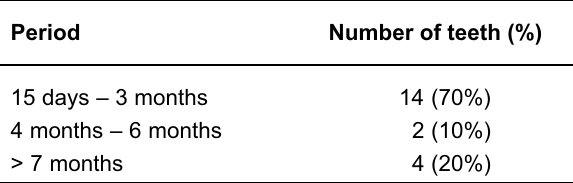
TABLE 2- Analysis of vertical percussion test (VPT) in relation to the presence of microorganisms in the root canal